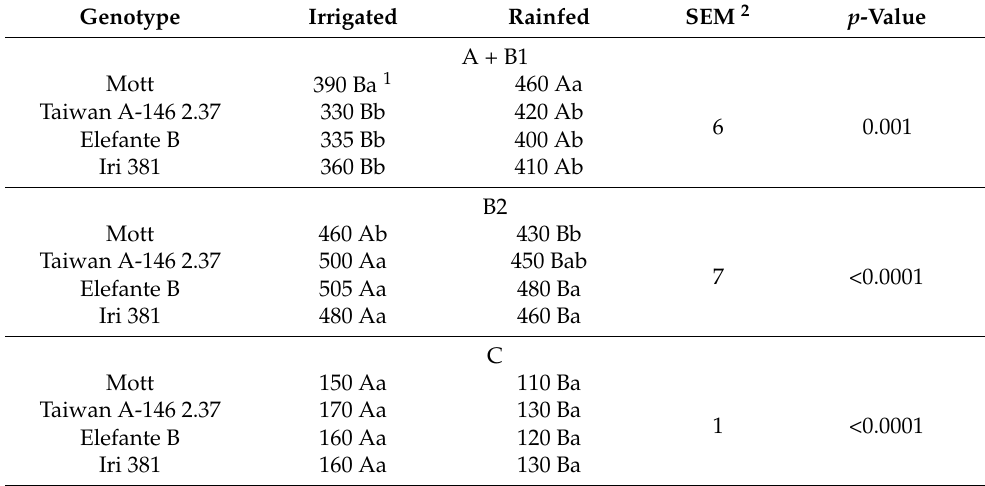
Table 11. Leaf carbohydrate fractionation (g/kg carbohydrate) as affected by the interaction between genotype and irrigation for elephantgrass genotypes at Garanhuns, Pernambuco, Brazil. Genotype